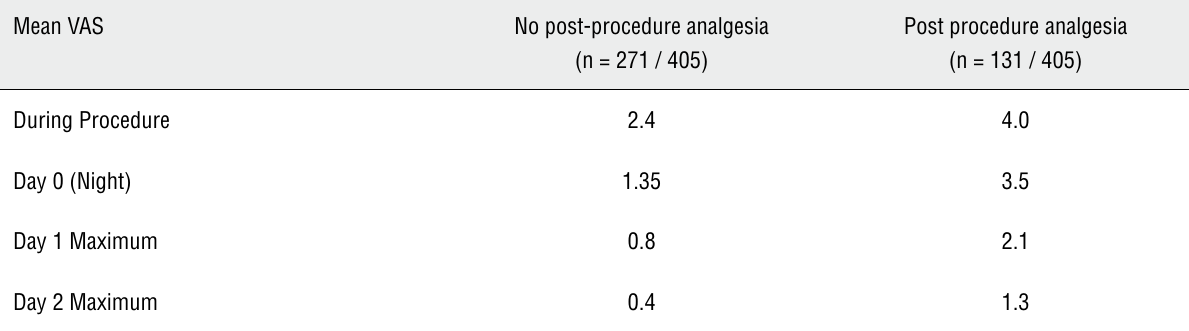
Table 1 – Comparative vAs between the patients who did and did not self medicate analgesia post procedure. Mean VAS No post-procedure analgesia (n = 271 /